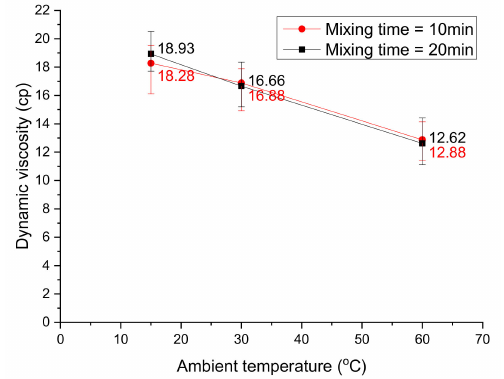
Figure 6. Viscosity changes by mixing time of W:D = 1.0 emulsions containing 0.2 wt% of mixed surfactant (HLB